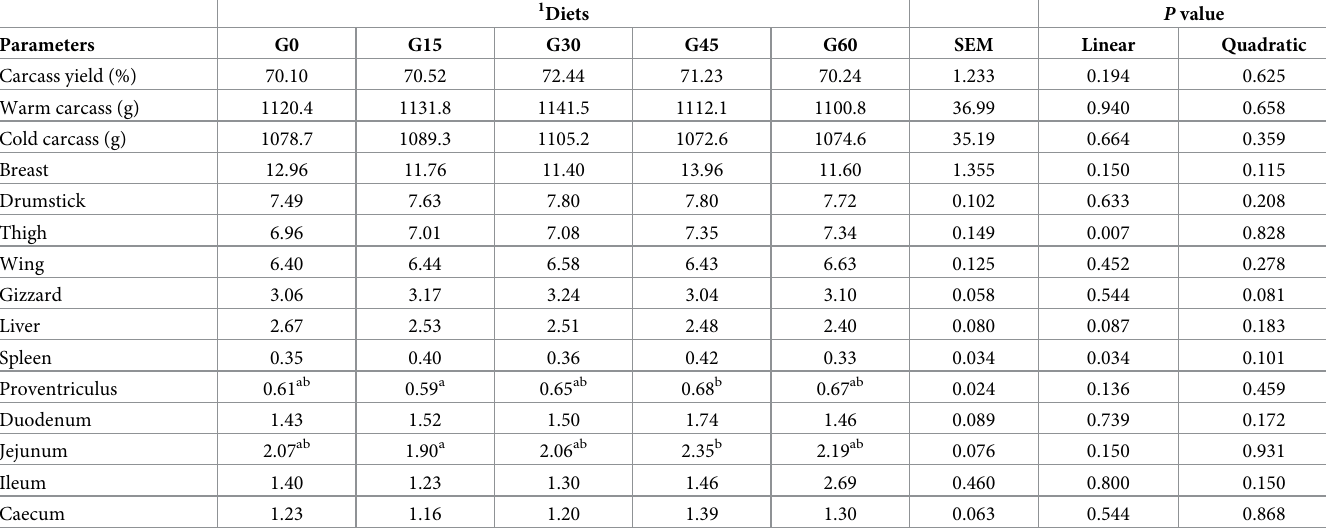
Table 6. Effect of red grape pomace-containing diets on carcass characteristics and visceral organ weights (g /100 g HCW) of Hy-Line Silver Brown cockerels. 1 Diets P value